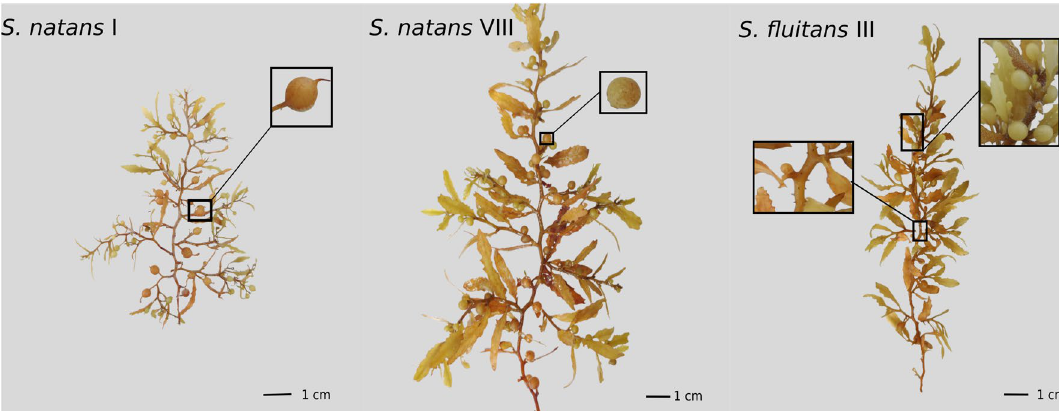
Figure 1. General appearance of the three pelagic Sargassum morphotypes collected on Morgan Lewis beach, Barbados. Inset on S. natans I shows the presence of spines on the circular air bladders. Inset on S. natans VIII shows the absence of spines on the circular air bladders. The top right inset on S. fluitans III shows the absence of spines on the elongated air bladders and the bottom left inset shows the presence of spines along the stem. Photograph taken from Ref. 38